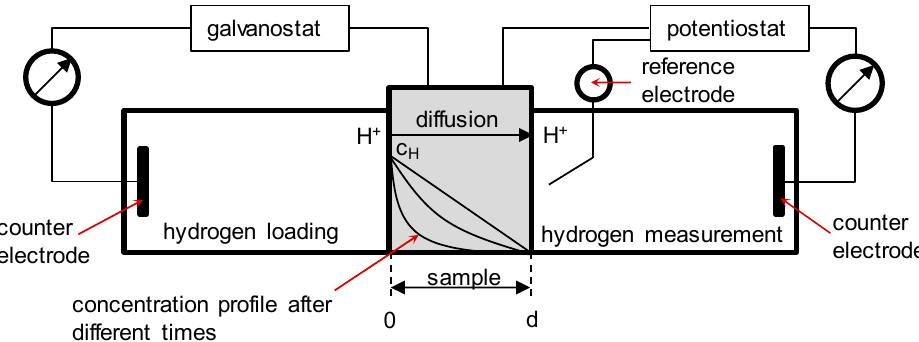
Figure 2. Schematic representation of a hydrogen permeation test based on [13].